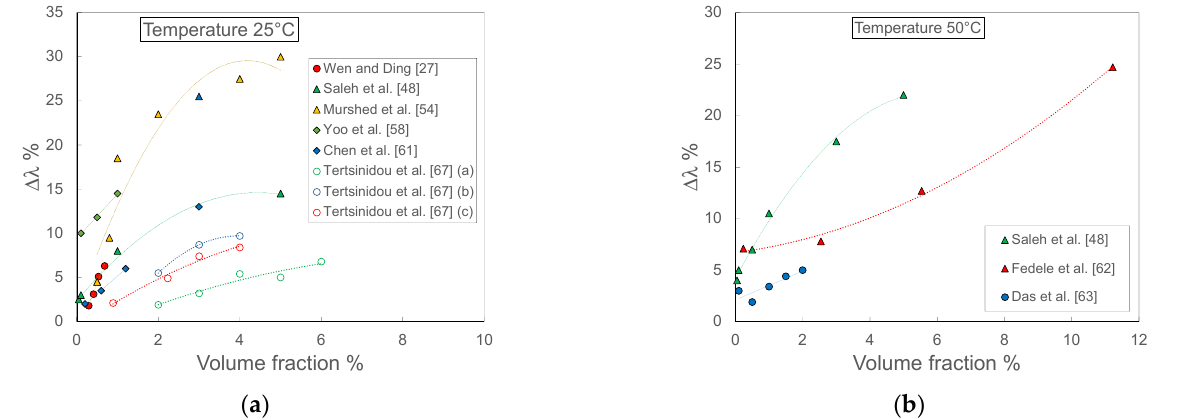
Figure 12. Thermal conductivity enhancement for TiO 2 -water nanofluids measured by different laboratories as a function of volume fraction at two different temperatures: ( a ) 25 °C; ( b ) 50 °C.